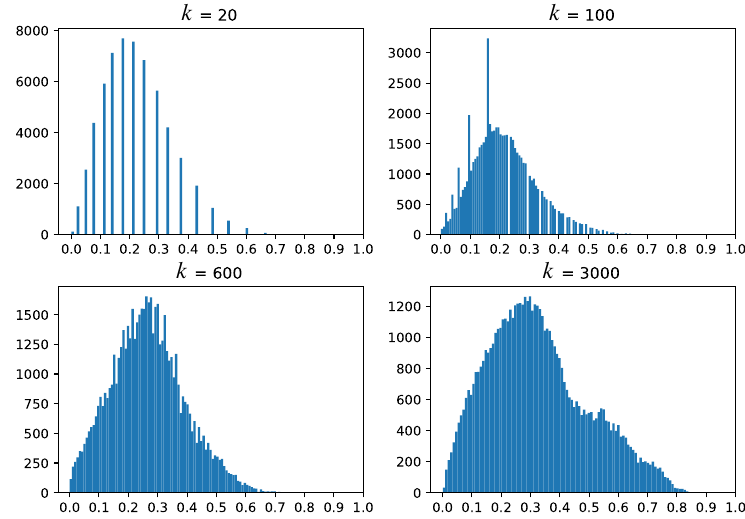
Figure 6. Histogram of JD k rank for varying values of k for MNIST dataset, t-SNE